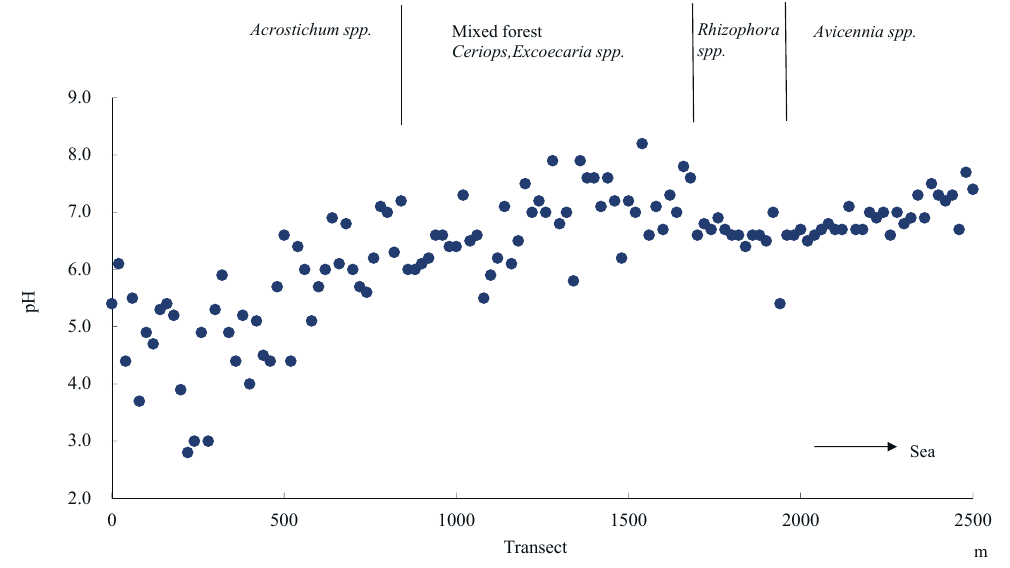
Figure 5. pH changes along the transect. The low pH in Acrostichum spp. zone is due to rapid OM